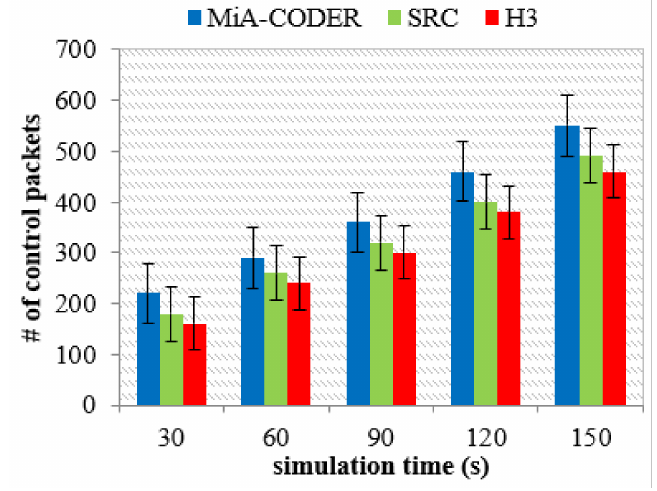
Figure 12. Number of control packets (before coverage hole repair) vs. simulation time.